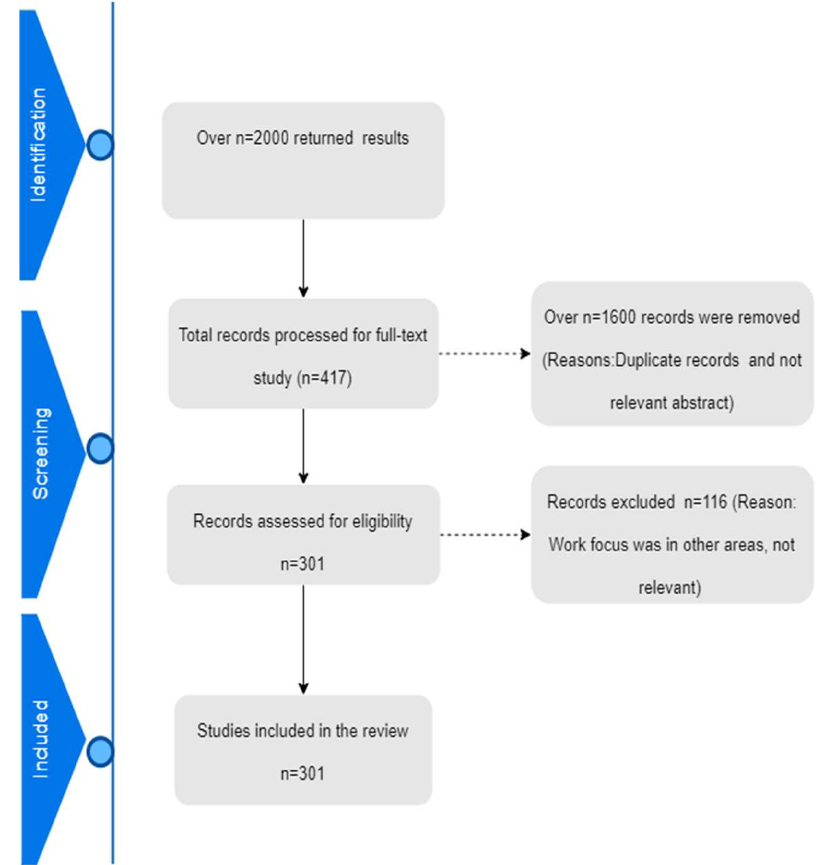
Figure 1. Research method.